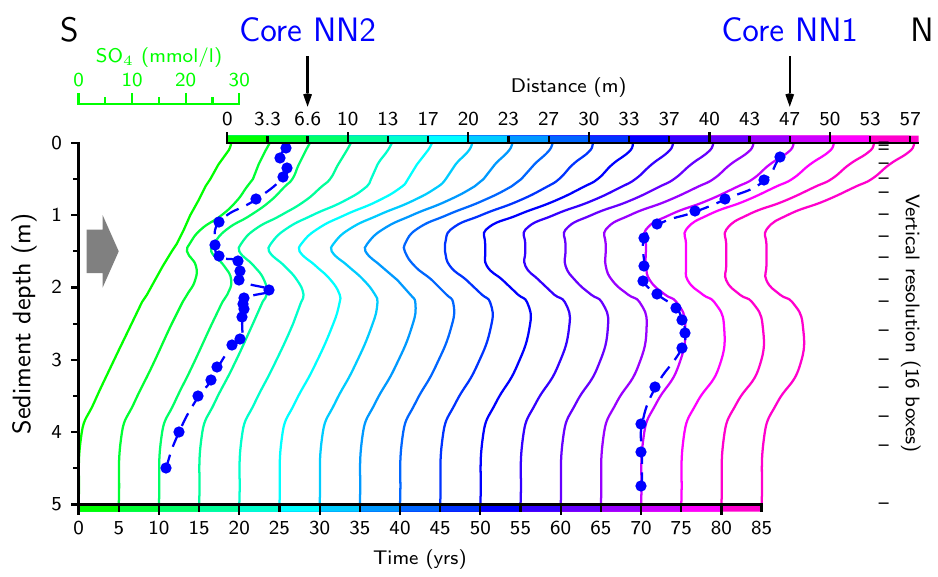
Fig. 10. Model pore water SO 4 evolution ( varicolored ) along the flow path with a degradation rate of intermediate POC of 0.7 × 10 − 4 d − 1 yielding best fits (minimal RMSE) for field data SO 4 pore water profile ( blue ). Pore water reaches NN2 after 10 years, approximately 7m from POC source, and for NN1 after another 60 years, 40m downstream of